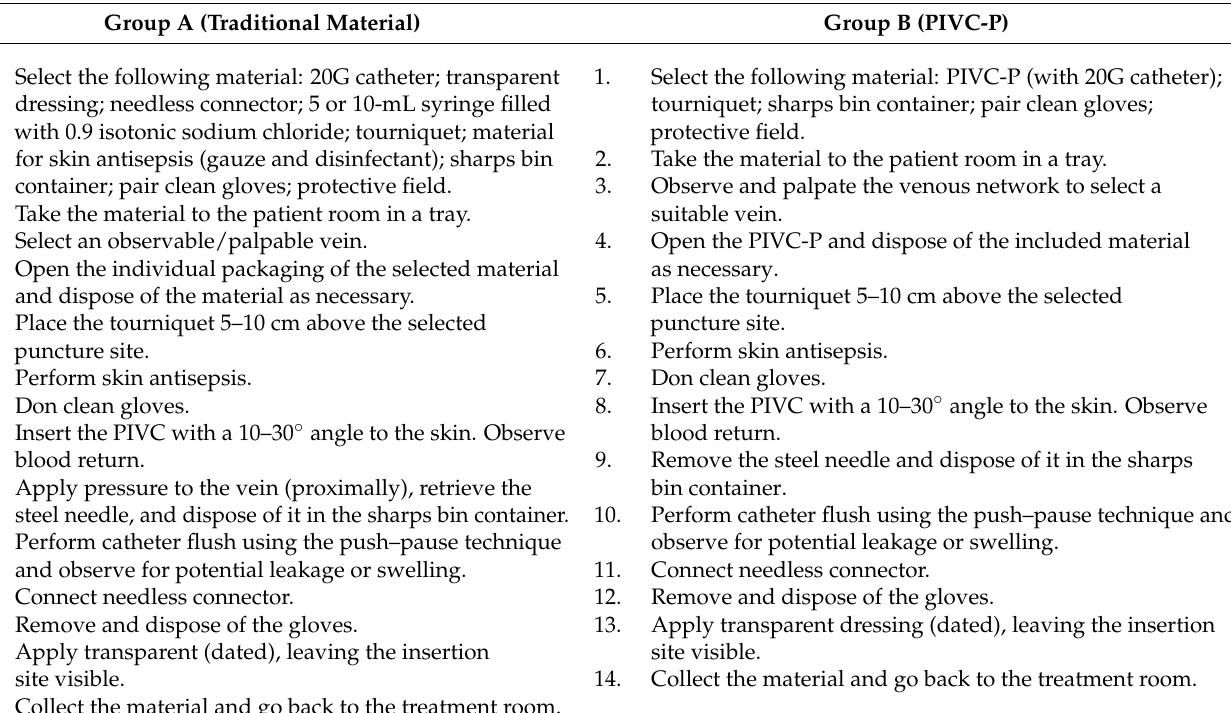
Table 1. Tasks to be accomplished by the study